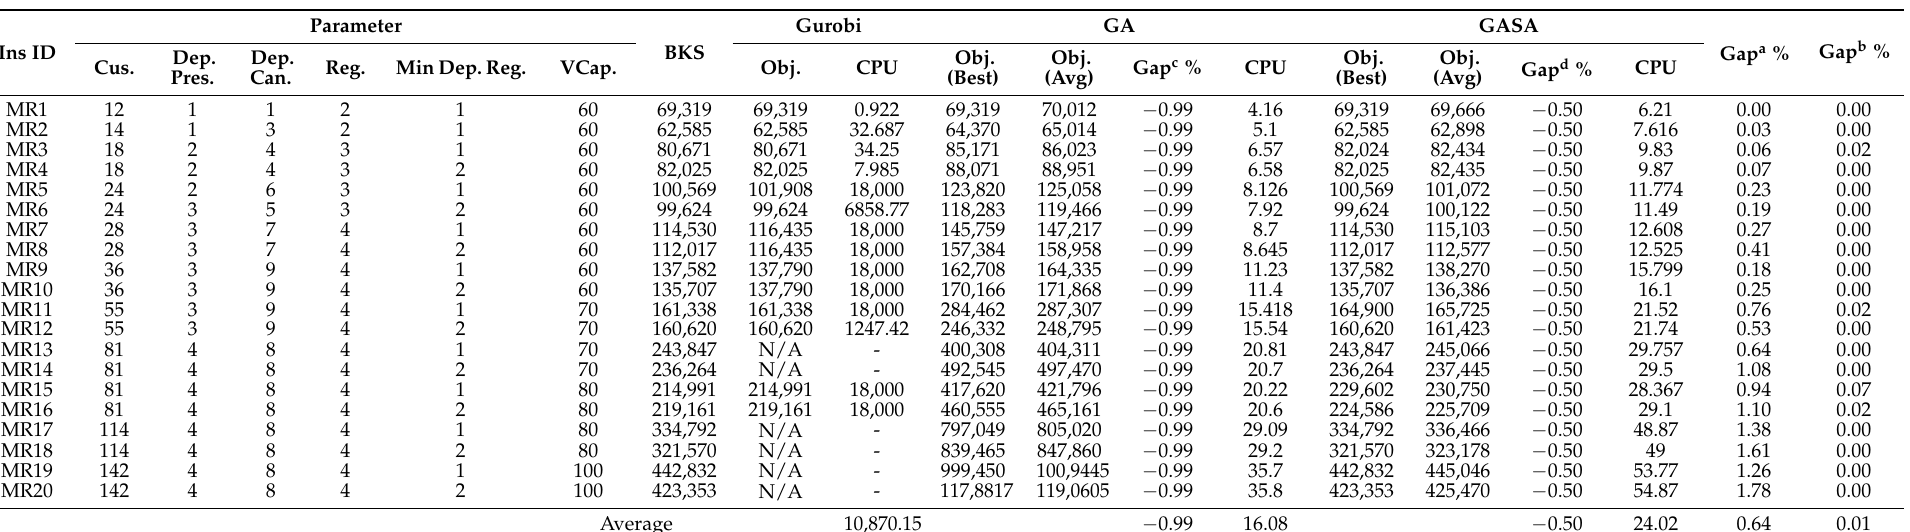
Table 4. Comparative objective value results for the MRLRP